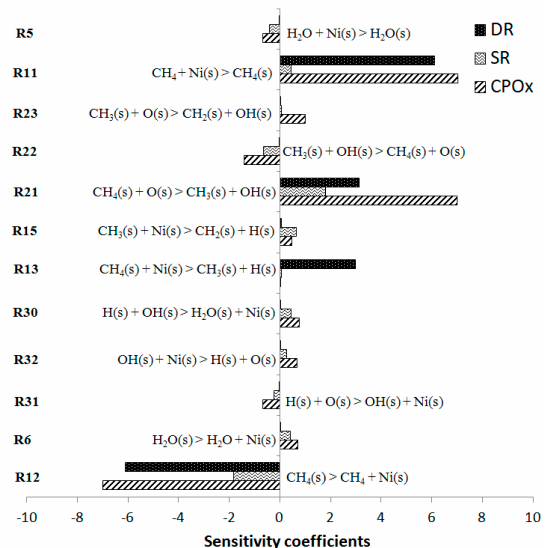
Figure 11. Sensitivity coefficients for CH 4 at 1073 K at DR, SR and CPOX conditions.